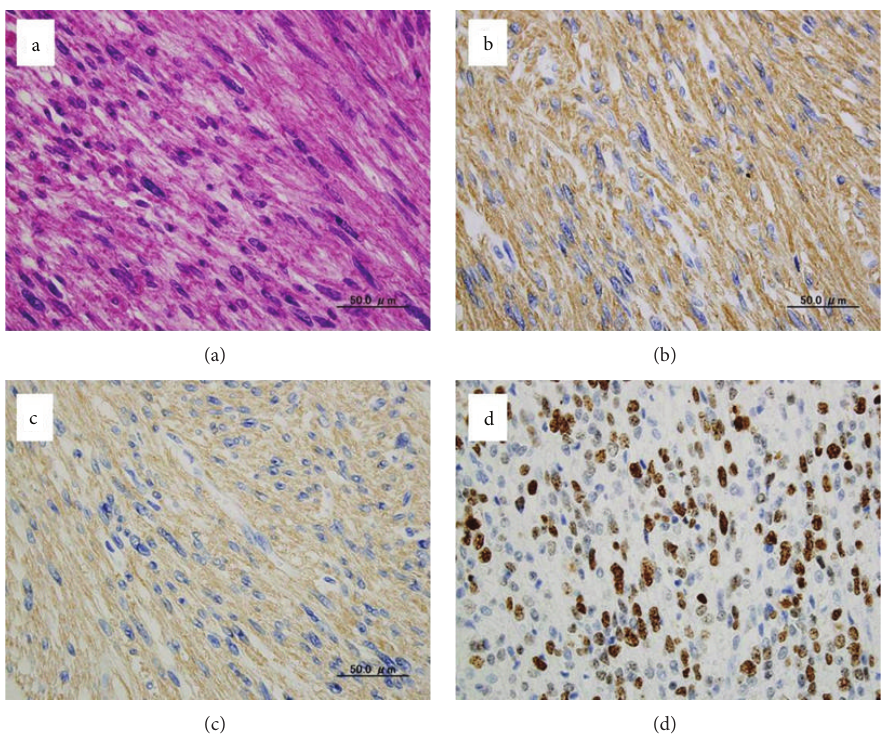
Figure 4: Histopathological findings. Microscopic examination revealed that the tumor consisted of uniform and spindle cells and had a fascicular growth pattern (Hematoxylin & Eosin: × 600) (a). Immunohistochemical staining revealed that 𝛼 -SMA ( × 600) (b) and HHF35 ( × 600) (c) were expressed in this tumor; MIB-1 index was about 60% (Ki67: × 600)